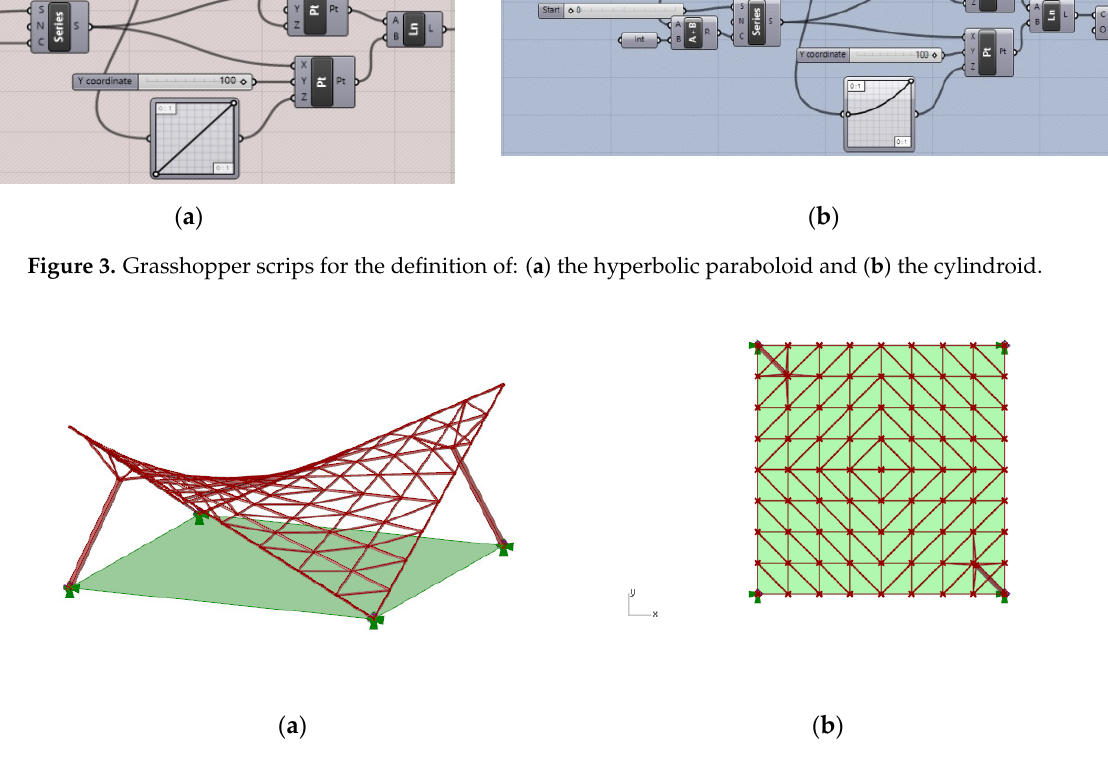
Figure 4. The hyperbolic paraboloid structure of type a (with a grid division along shorter diagonals): ( a ) an axonometric view; ( b ) an orthographic projection.